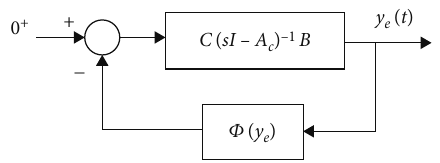
Figure 2: A structure of the Hyperstable system.